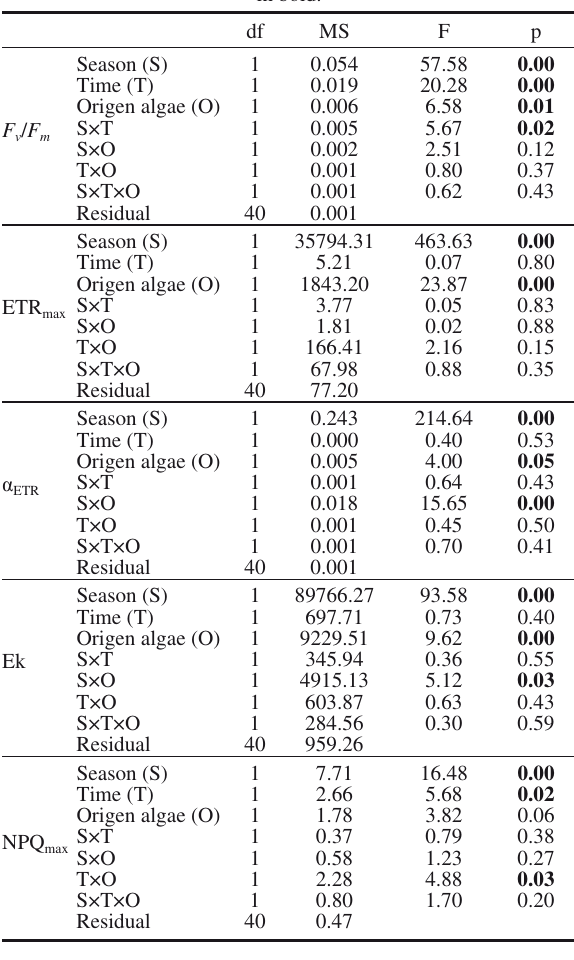
Table 2. – ANOVA results testing for the effect of Seasons, Time and Origin of algae (RP; RS) on the photosynthetic parameters;